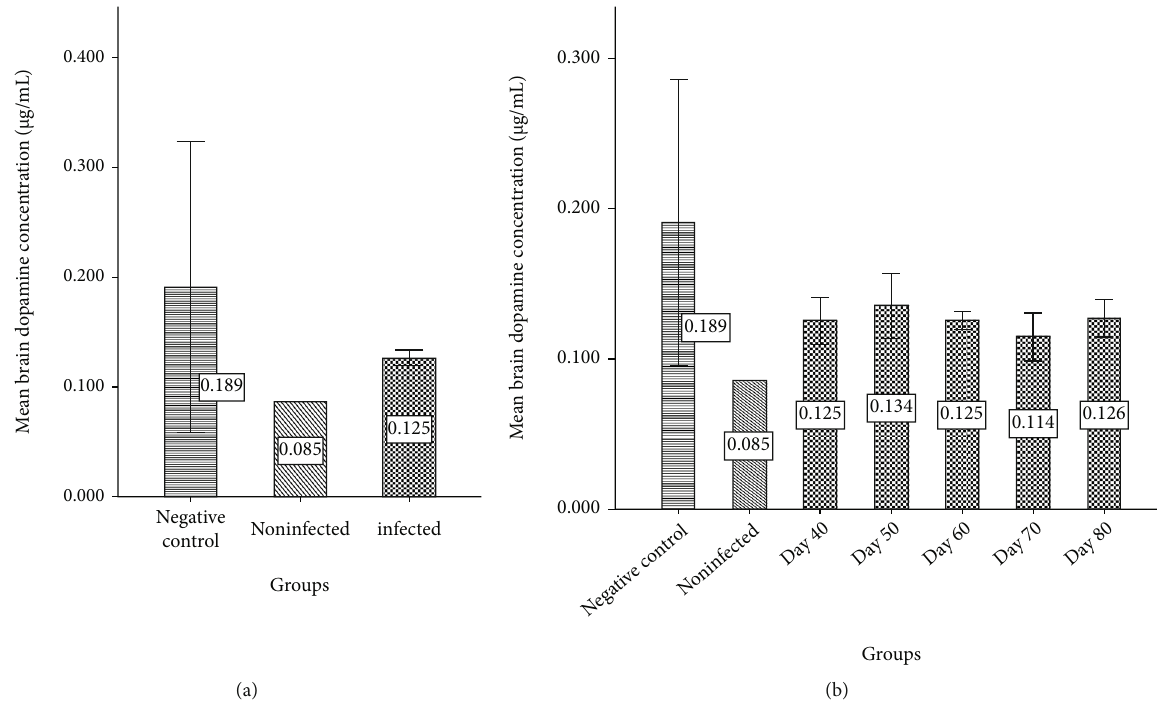
Figure 7: The average dopamine level ( μ g/ml) of the brain in negative control, PD uninfected mice, and PD mice infected with Toxoplasma . (b) The average brain dopamine of the PD mice infected with Toxoplasma at days 40, 50, 60, 70, and 80 in comparison with negative control and PD uninfected